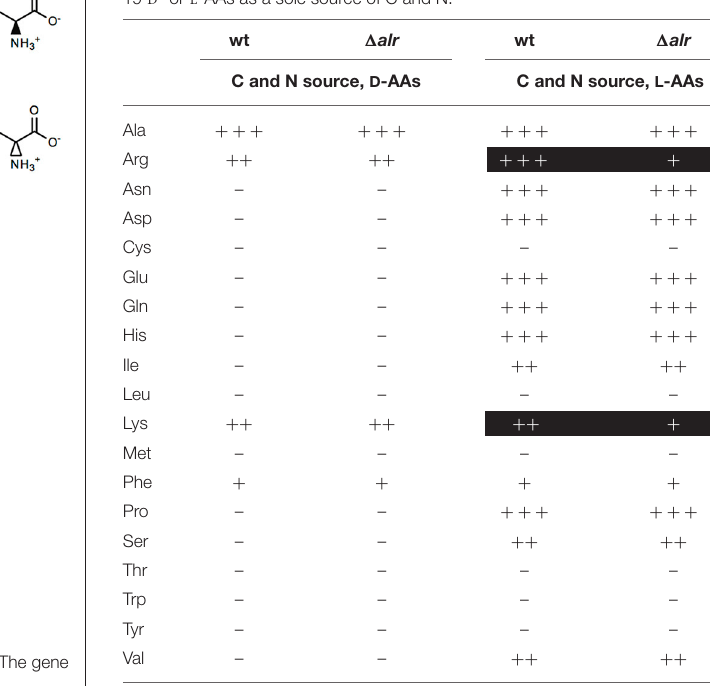
72h of incubation; Growth assays were performed in triplicate. The shading highlights the only significant differences (p < 0.05, Student’s t-test) between the two